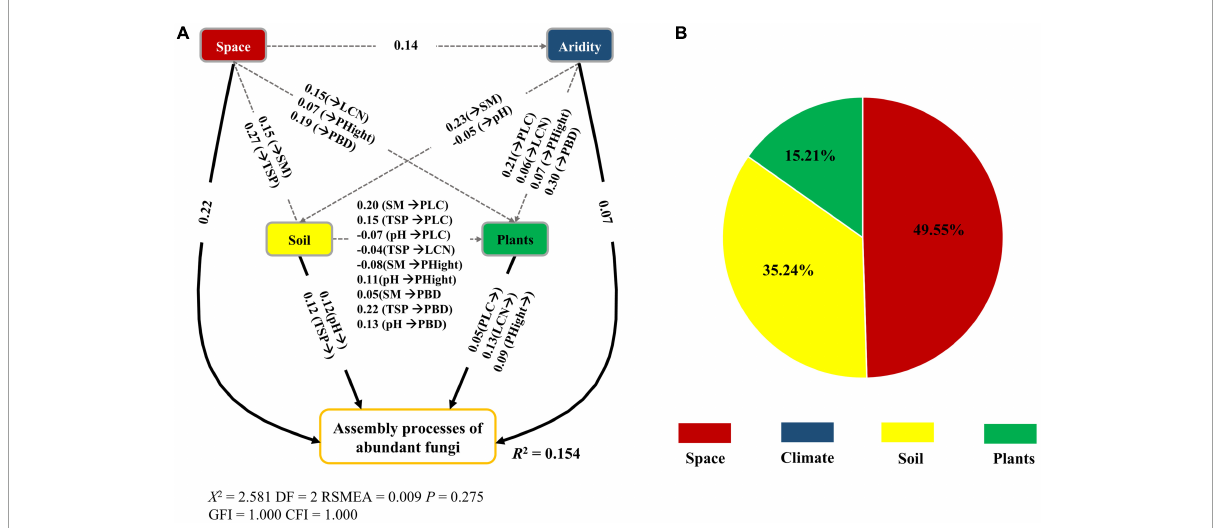
FIGURE6 Direct and indirect effect of spatial and environmental variable on the assembly processes of abundant fungi (A) , and the relative influence of spatial, abiotic (soil and climate), and plant attributes on the assembly processes of abundant fungi (B) . Only significant links were reported ( P < 0.05). Space, spatial variables.